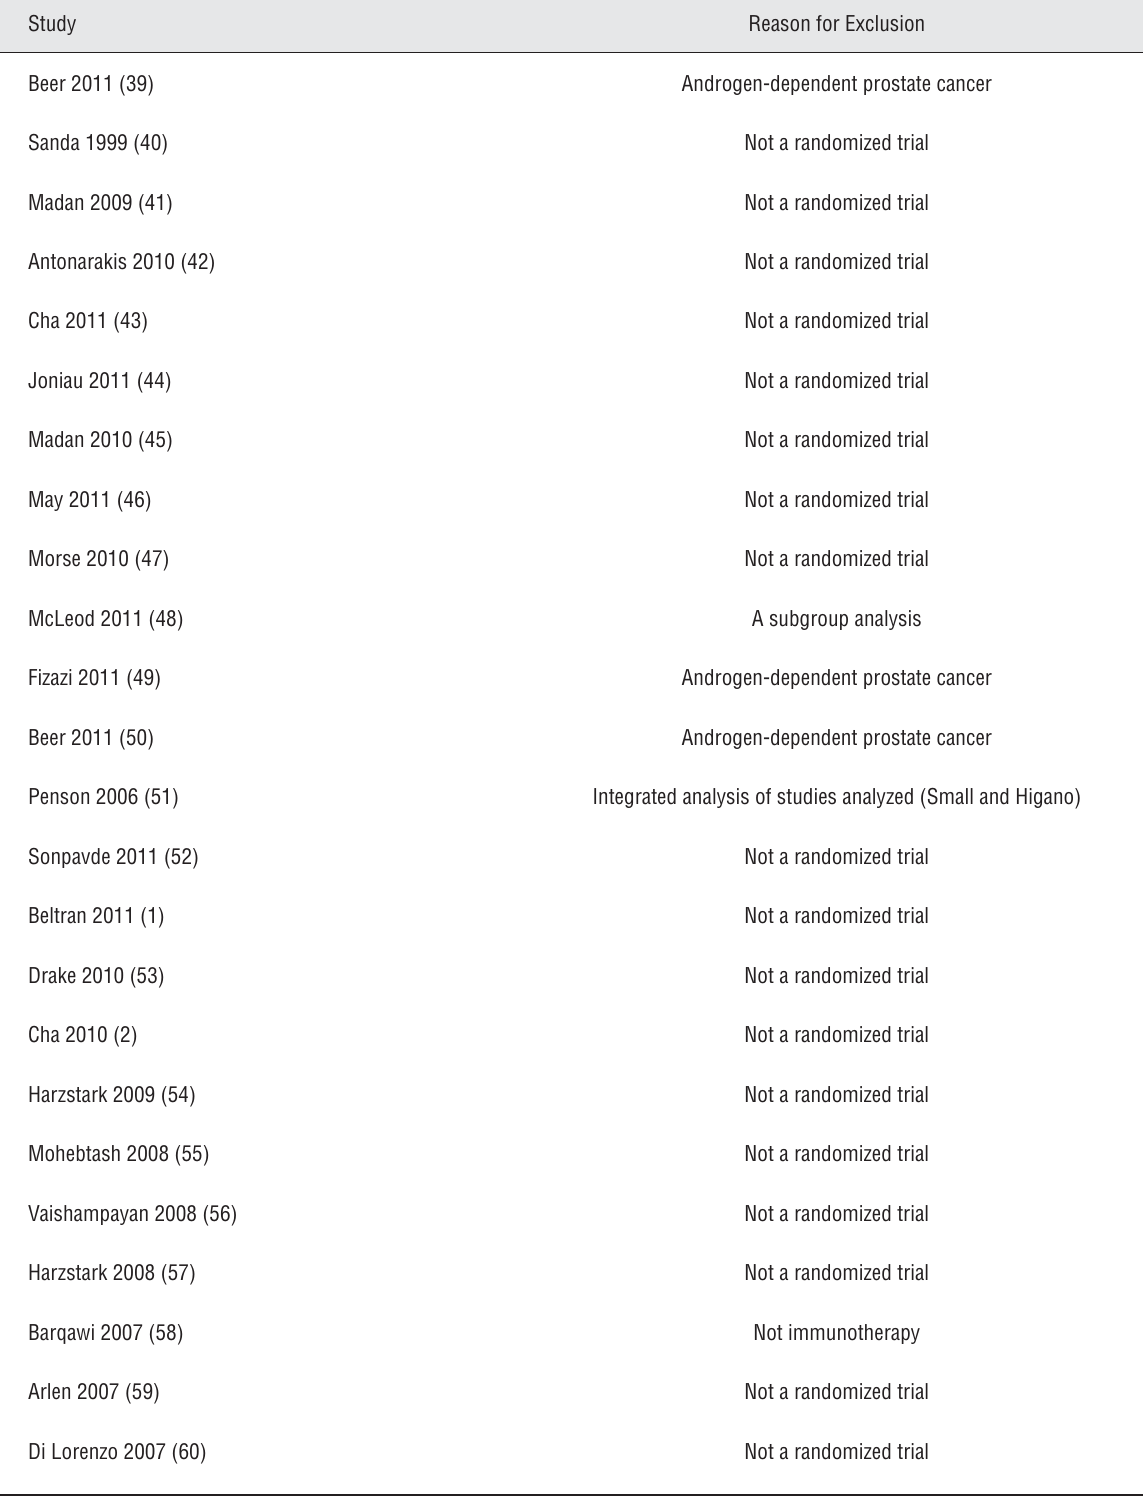
Table 1 - Characteristics of Excluded